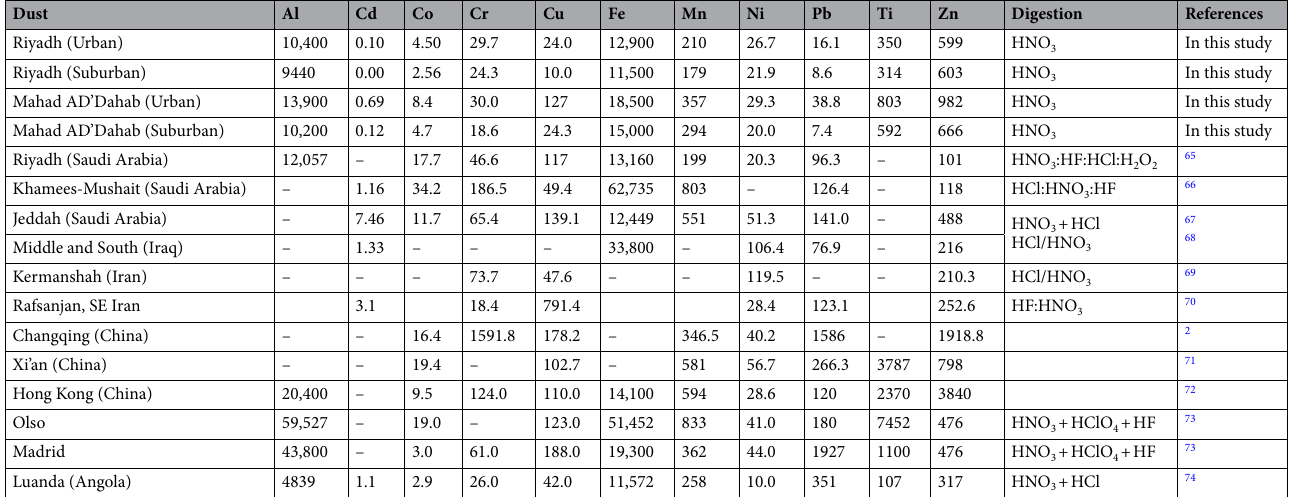
Table 2. Average concentrations of heavy metals (mg kg −1 ) in dust of urban and suburban areas and their comparison with those reported for other